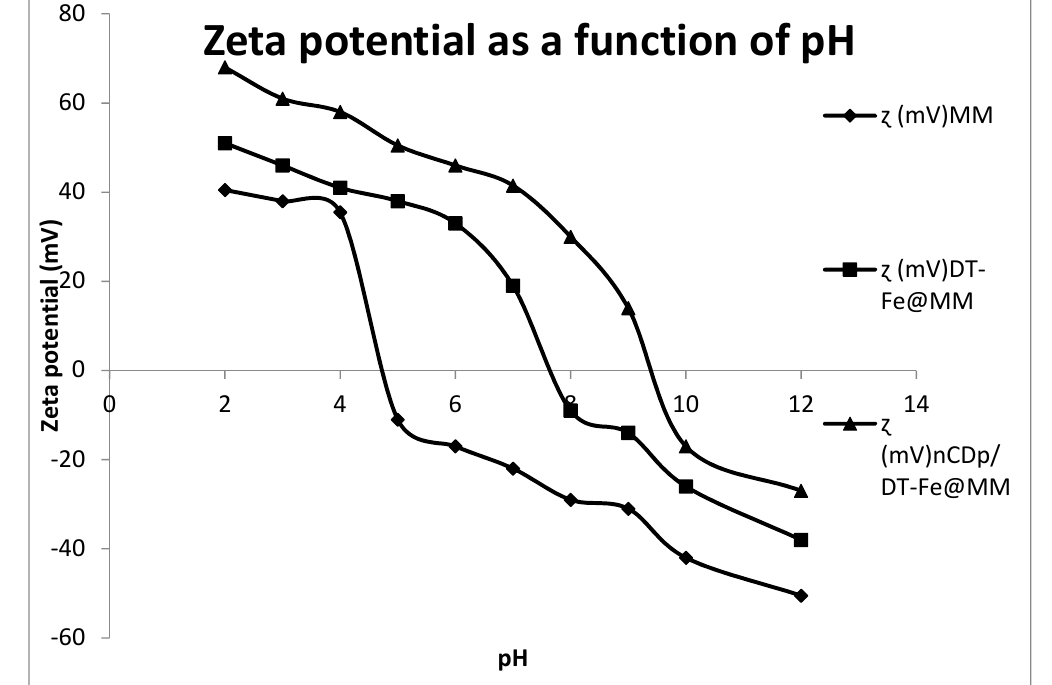
Figure 8. Zeta potential of unmodified and modified montmorillonite adsorbents as a function of pH.